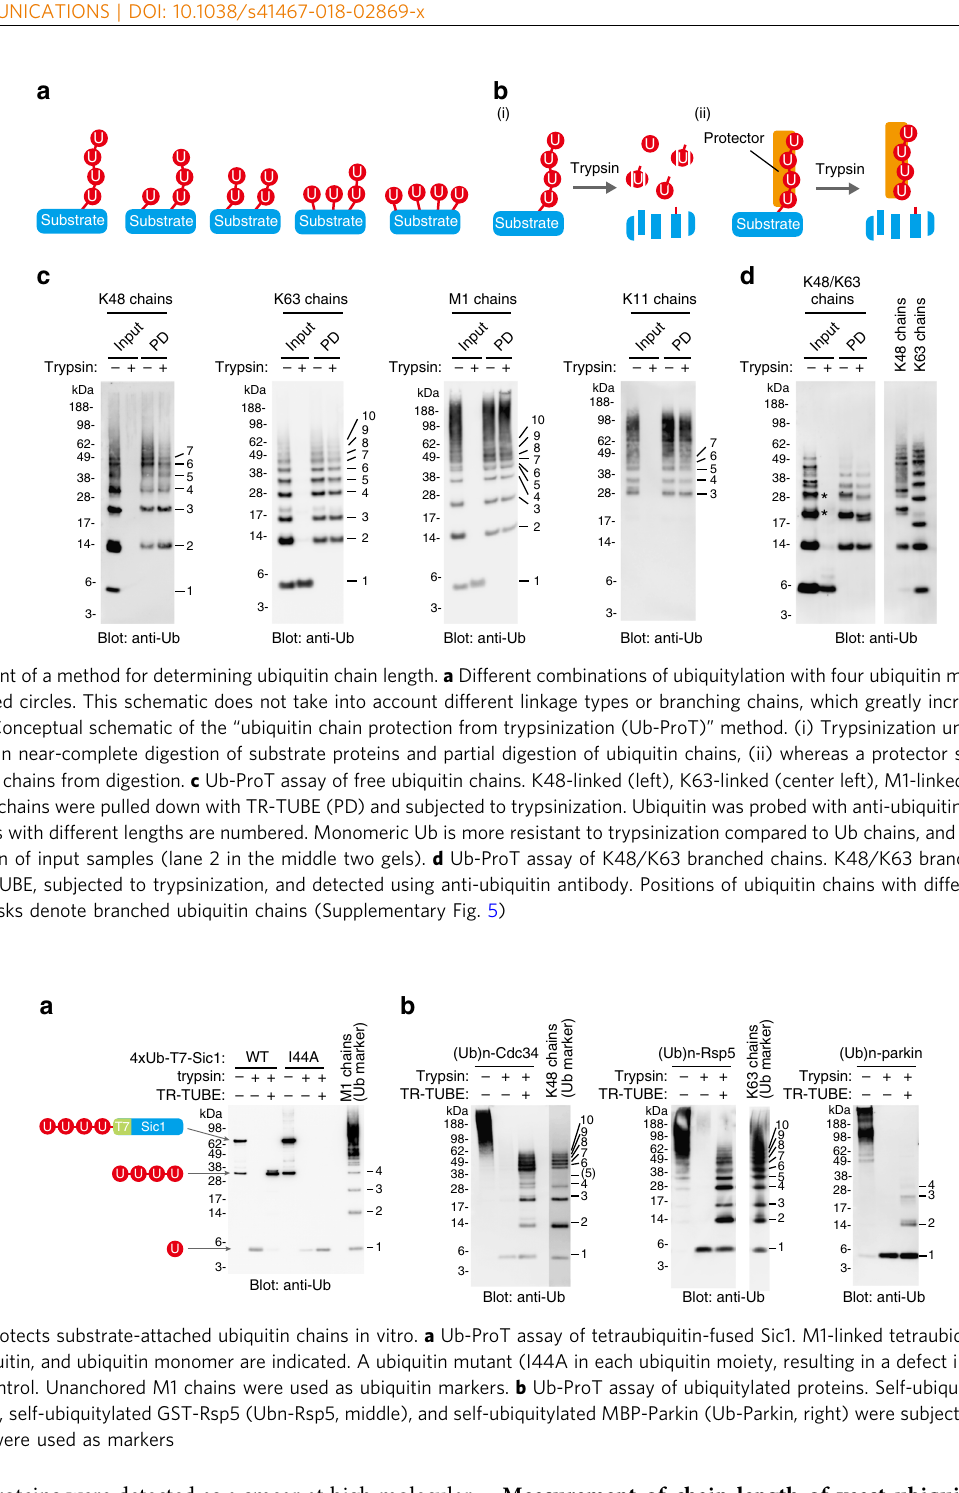
chains (used as a length marker) revealed that Cdc34 and Rsp5 were modi fi ed with K48- and K63-linked chains, respectively, of up to ~10-mers (Fig. 2b, left and middle). In contrast, self- ubiquitylated Parkin was modi fi ed with monoubiquitin and, to a lesser extent, short Ub chains (Fig. 2b, right). Because TR-TUBE captured almost all ubiquitylated Parkin, we concluded that TR- TUBE can bind not only Ub chains but also multiply monoubiquitylated substrates.